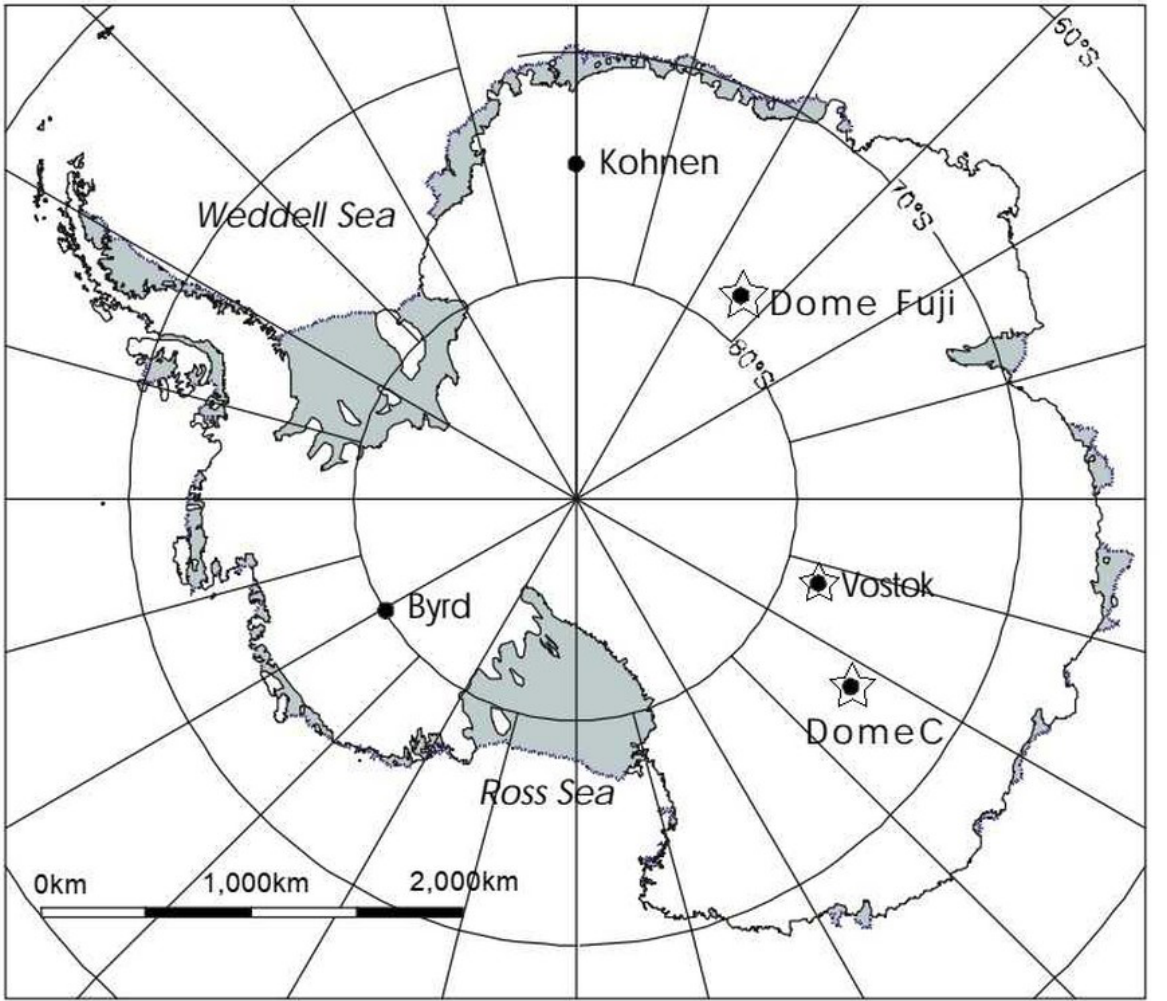
Figure 1. Map of the Antarctica region [9]. The positions of the weather stations, where the ice samples studied subsequently were taken, are marked with